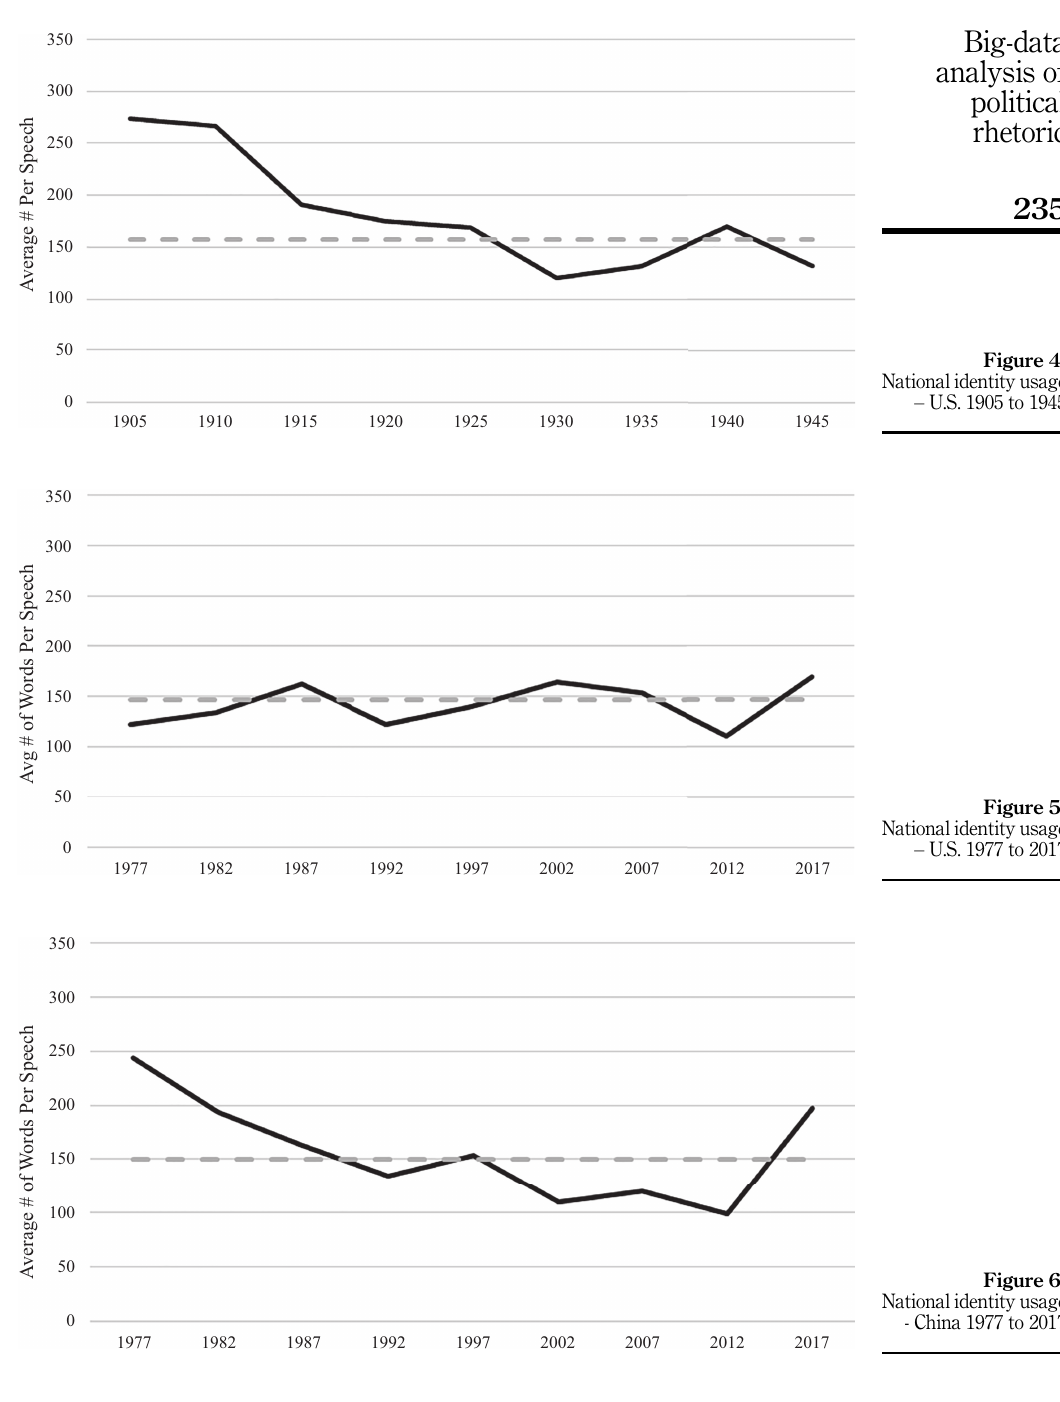
Figure 4. National identity usage